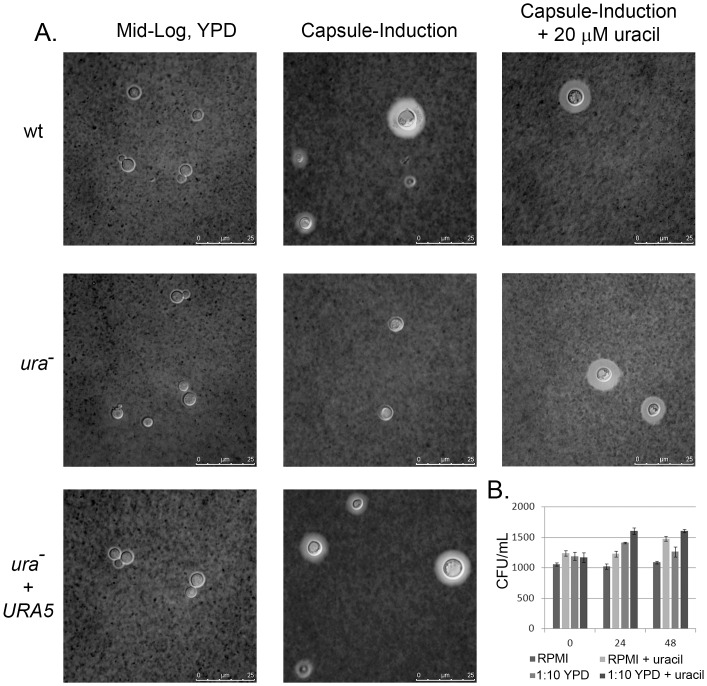

C. neoformans ura
− mutants exhibit capsule defects.(A) Representative images of capsule in wt, C. neoformans ura
− mutant and ura
− complement strains post induction in 1X RPMI at 37°C for 72 hours. (n = 100, represents number of cells measured) (B) Graph representing CFU +/− SEM of C. neoformans ura
− mutant in capsule inducing conditions to demonstrate the viability of cells in 1X RPMI or 1∶10 diluted YPD.